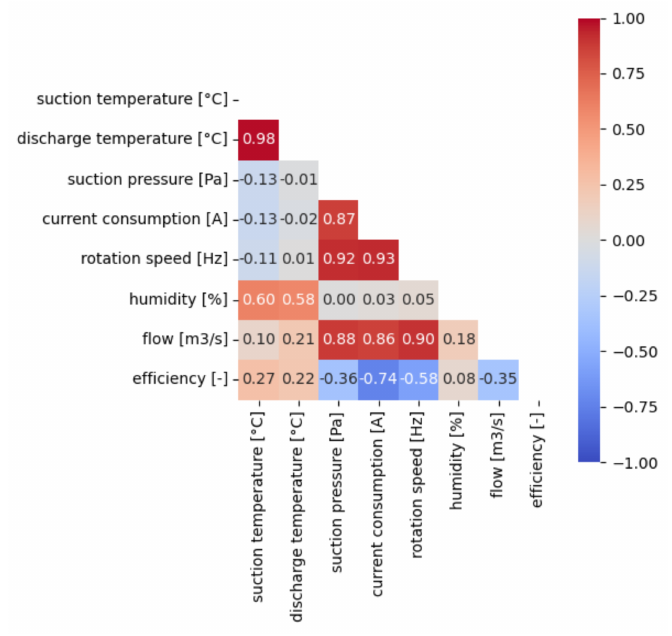
Figure 5. Pearson’s mutual correlations between parameters and efficiency.